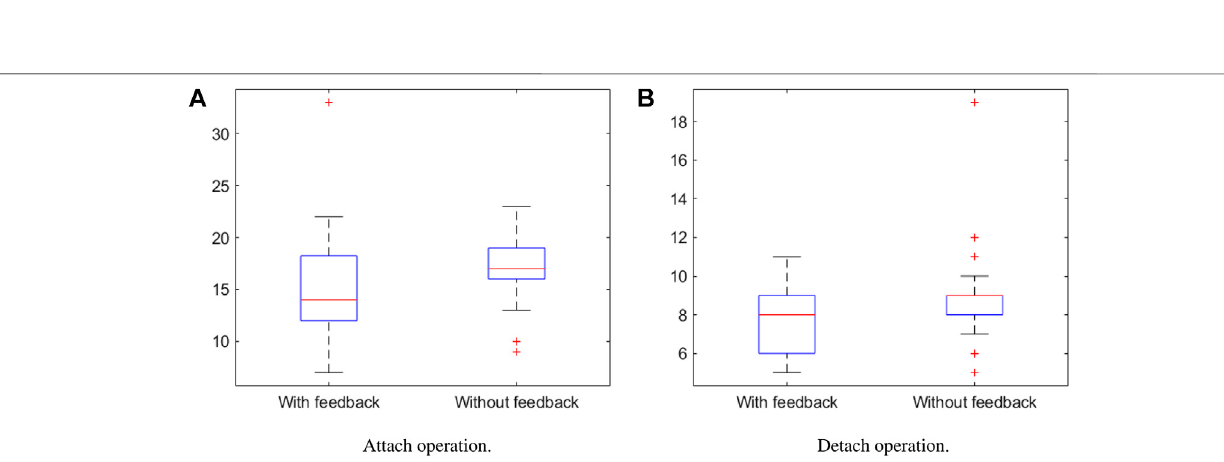
Frontiers in Robotics and AI |